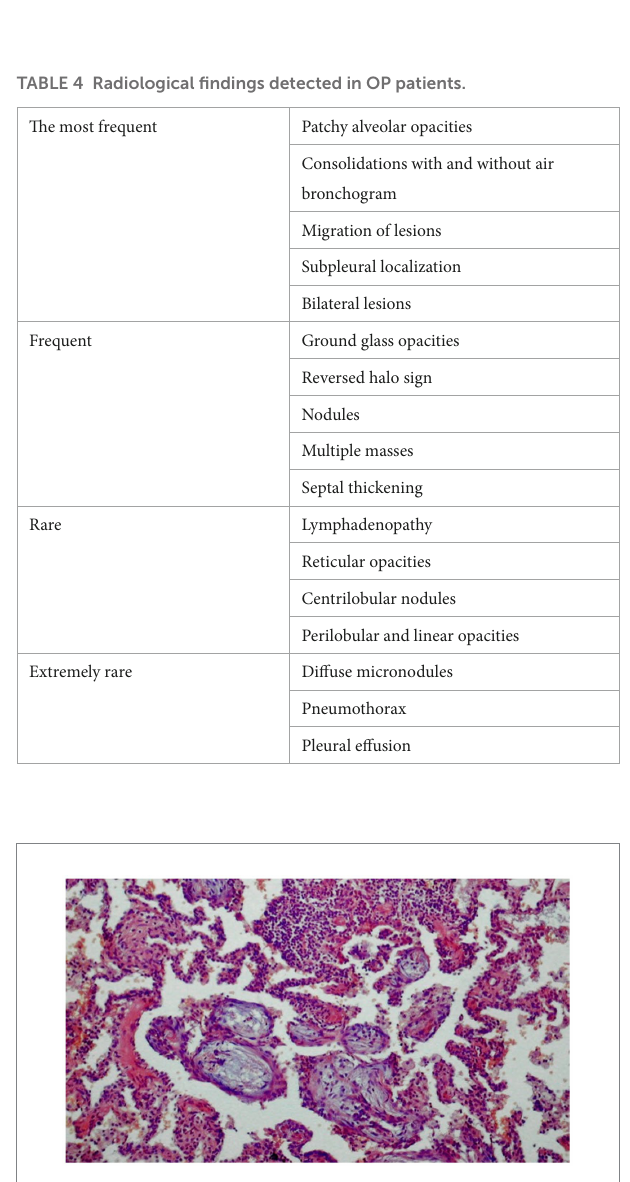
FIGURE 7 Histological image of organizing pneumonia (H-E). Alveoli filled with loose tissue forming polypoid formations extending into the respiratory tracts with a small diffuse inflammatory infiltrate in the interalveolar